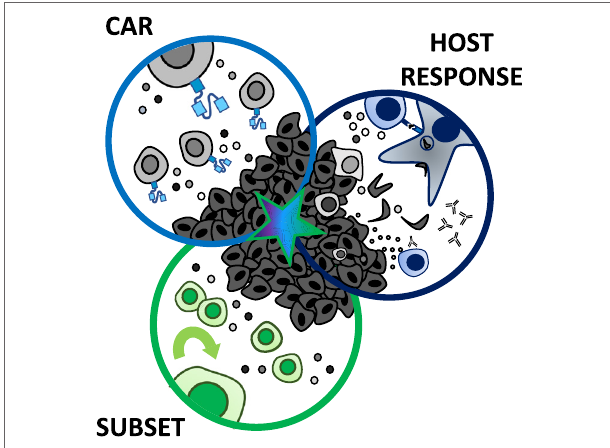
FigURe 1 | Three-pronged approach to improve chimeric antigen receptor (CAR) T cell therapies in solid tumors. A multi-faceted attack on solid tumors resistant to standard CAR T cell therapies may best augment their efficacy in clinical trials. The ultimate CAR T cell therapy should encompass three axes: (1) a CAR with high fidelity targeting of more than one tumor antigen and trafficking capacity, (2) selection of a T cell subset with potent self-renewal and migratory capacity for long-term persistence and immunity, and (3) ability to harness and rejuvenate the host response to tumor neoantigens. A single arm (CAR, subset, or host response) has not been sufficient for long-term responses against aggressive solid tumors to